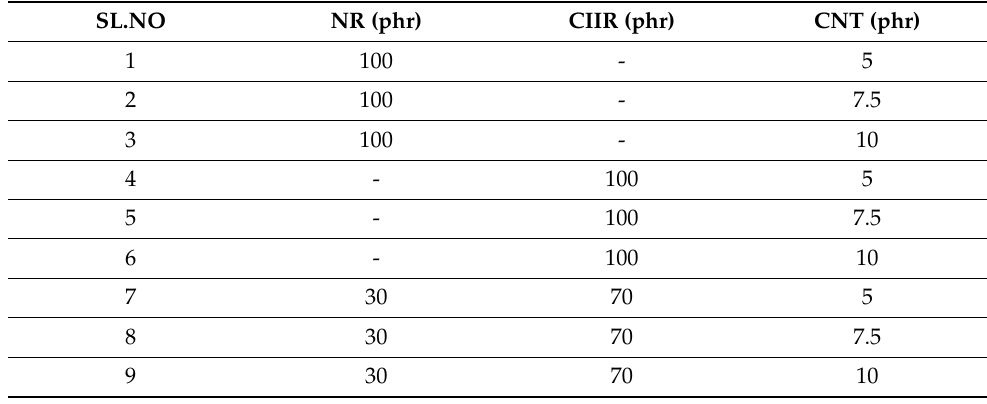
Table 2. Composition of rubber nanocomposite with different filler